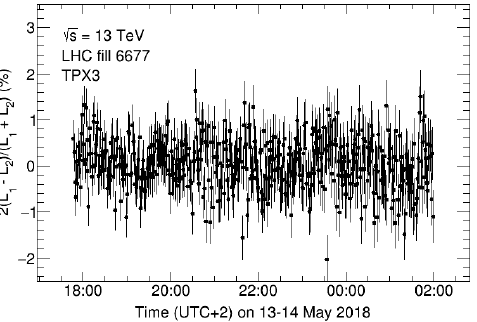
Figure 65. Relative difference between the luminosities measured by layers 1 and 2 of the TPX3 device as a function of time, using cluster-counting in LHC fill 6677. The TPX3 data are grouped into LB time periods of typically 60s. Statistical error bars are shown. Taken from Ref. [18].